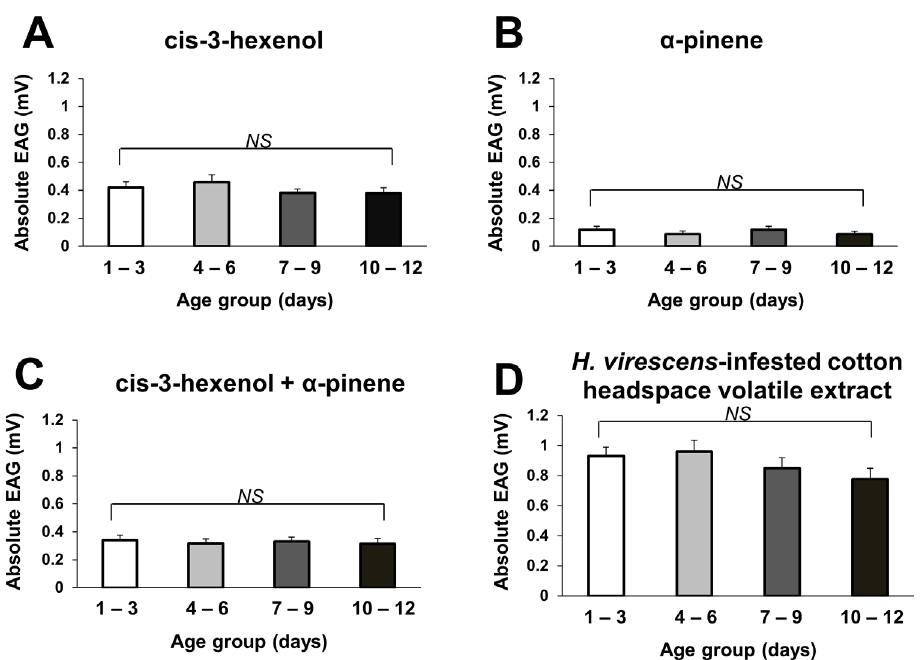
Figure 2. Effect of age on the electroantennogram (EAG) response of mated female Microplitis croceipes to four host-related plant odors. Bars represent mean absolute EAG responses (mV± SE, N = 10) of mated parasitoids age 1–3, 4–6, 7–9 and 10–12 d-old to cis -3-hexenol ( A ), α -pinene ( B ), a 50/50 v/v binary mixture of cis -3-hexenol and α -pinene ( C ), and Heliothis virescens -infested cotton headspace volatile extract ( D ). Absolute EAG for each stimulus is the actual EAG value minus EAG value of solvent control. Synthetic compounds were formulated in hexane at 1 µg/µl and presented as 10 µl samples (10 µg dose). NS indicates no significant